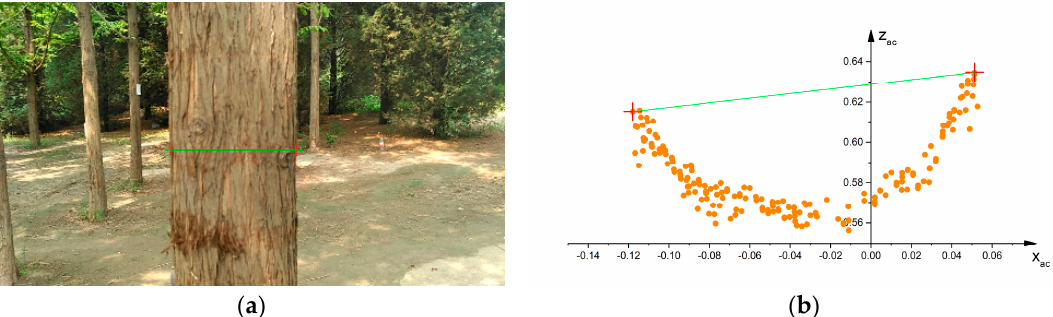
Figure 12. The stem boundary detection result after linear fitting: ( a ) The boundaries in the RGB image; ( b ) The boundaries on the plane O ac − x ac − z ac .